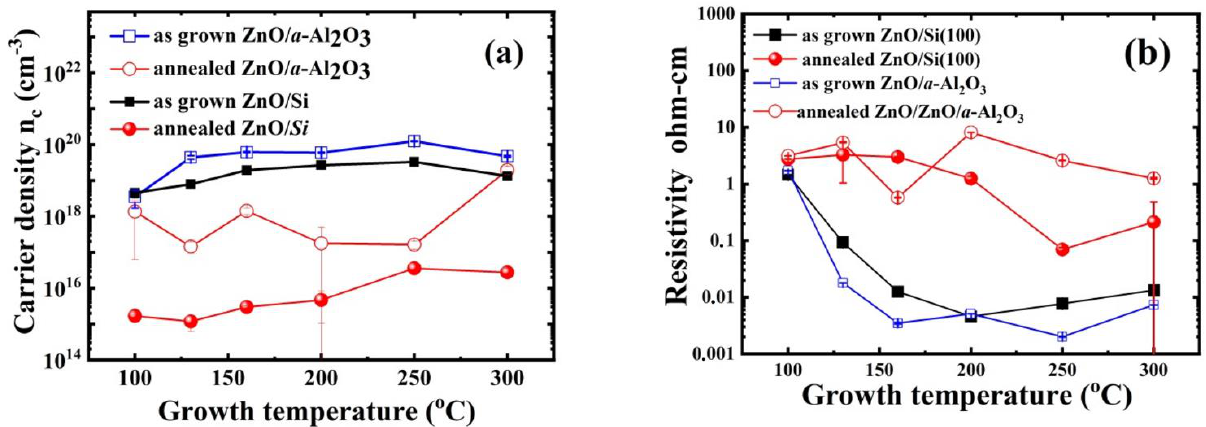
Figure 10. ( a ) Carrier density and ( b ) resistivity versus T g for as grown and annealed ZnO/ a -Al 2 O 3 and ZnO/Si(100). Table 4. Electrical parameters and thickness of as grown and annealed ALD- ZnO/Si(100) thin films (mobility of annealed samples is not included, see explanation in the text, p . 14, lines 506–508). As Grown Samples Carrier Density n c T g ( ◦ C) (cm − 3 )/Mobility(cm 2 /Vs)